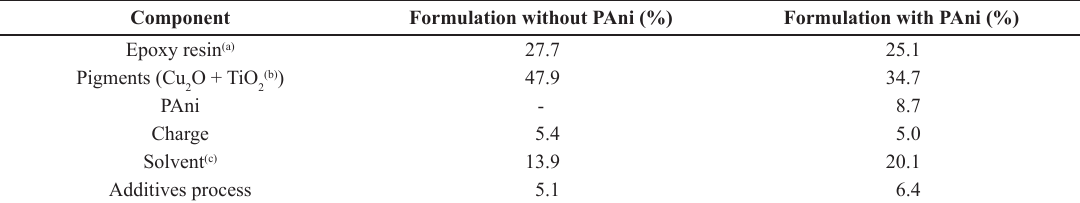
Table 1. Paints composition.